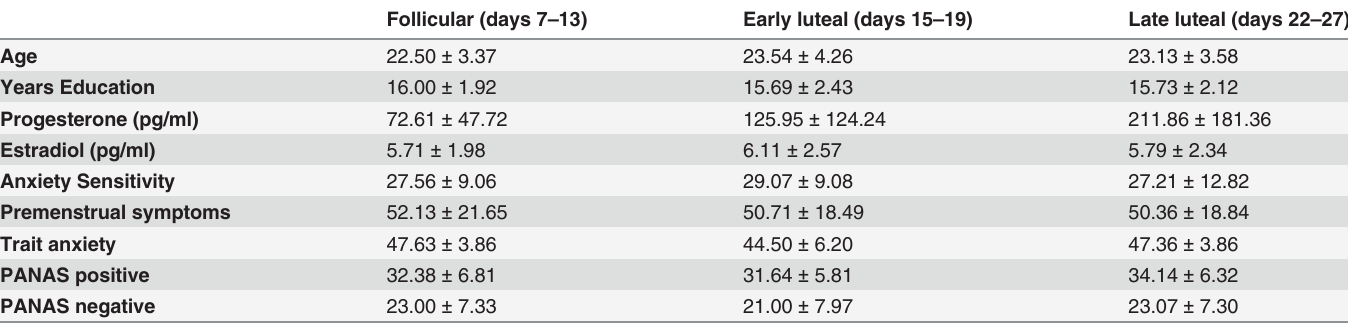
Table 1. Demographic, endocrine and mood-related characteristics of the follicular (n = 16), early luteal (n = 14) and late luteal (n = 14) cycle phase groups (mean ±